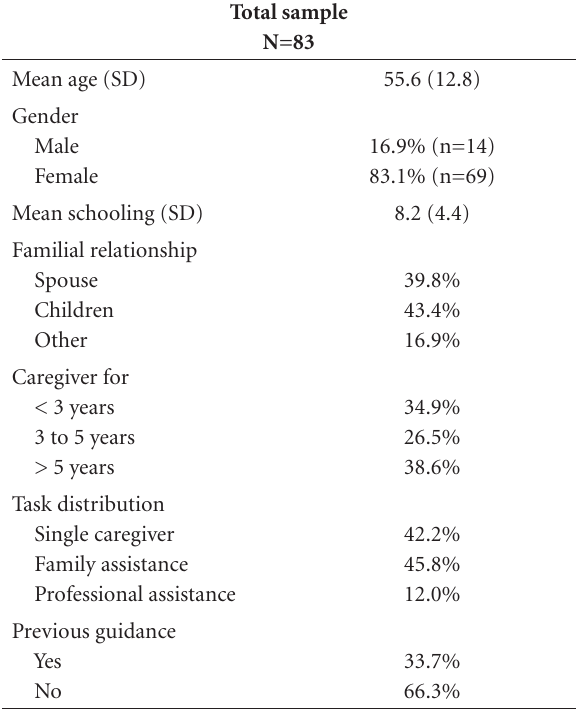
Table 1. Sociodemographic profile and caregiving characteristics of family caregivers.